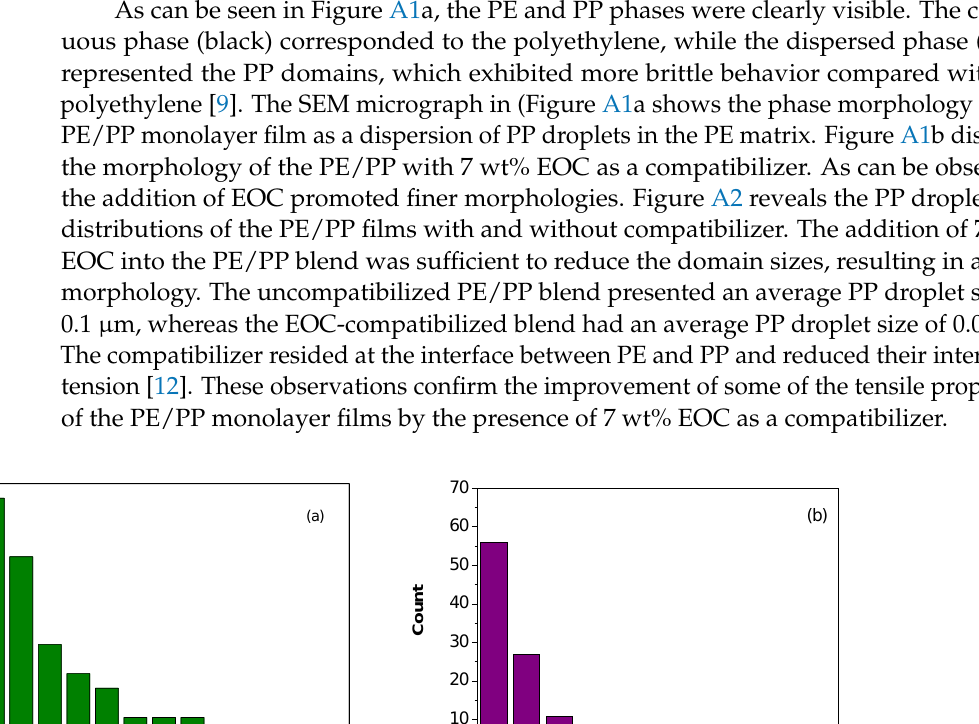
Figure A1. High-vacuum SEM images of PE/PP monolayer films: ( a ) PE/PP (90/10) (without compatibilizer) and ( b ) PE/PP/EOC (83/10/7).